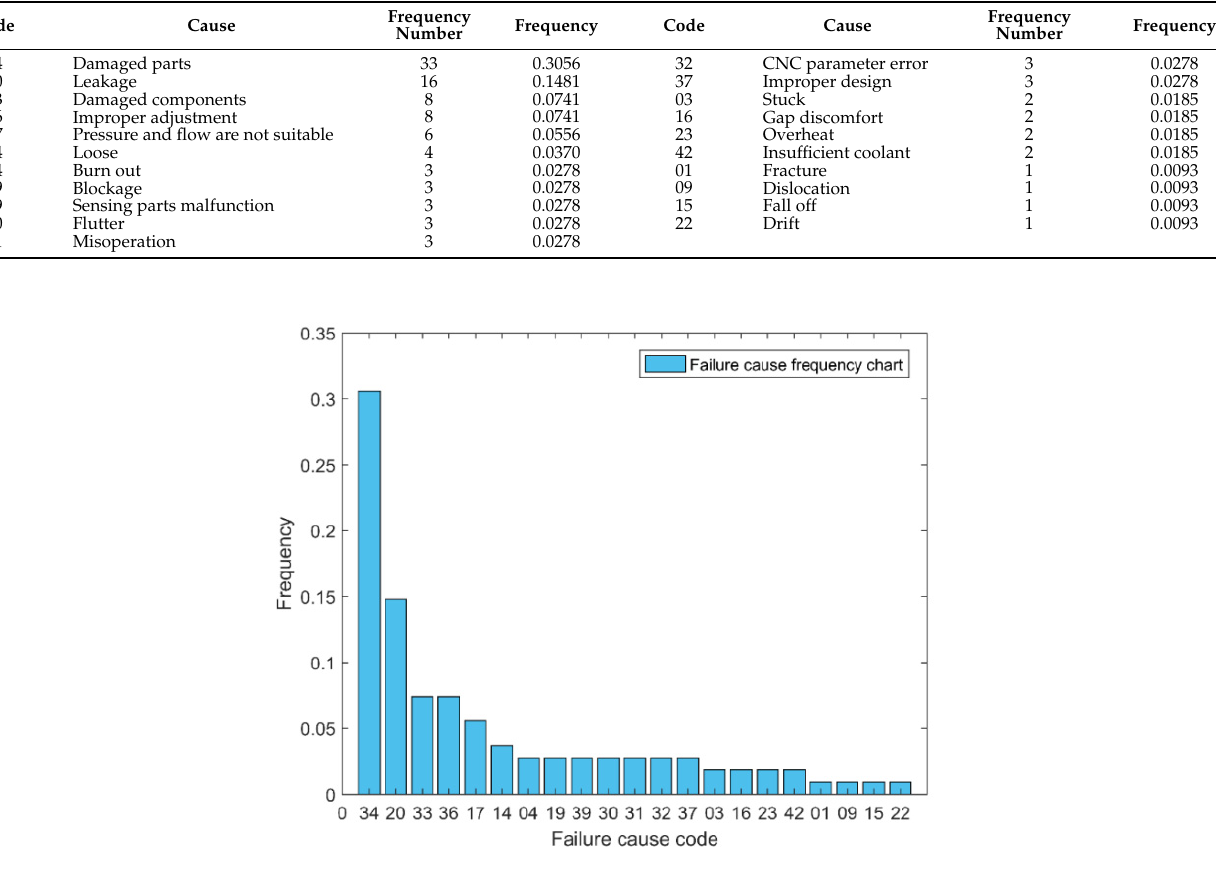
Figure 6. Frequency chart of failure causes of machining center.